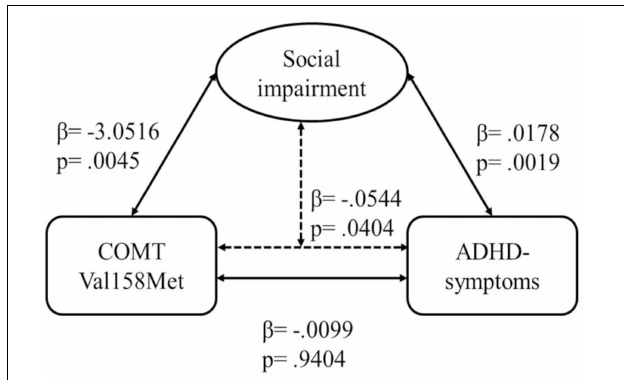
FIGURE 2 | Moderation analysis for effects of COMT Val158Met genotype on ADHD symptom strength via social impairment. The association between COMT and ADHD symptom strength was significant when the measure of social impairment was included in the model; Sobel test: p =